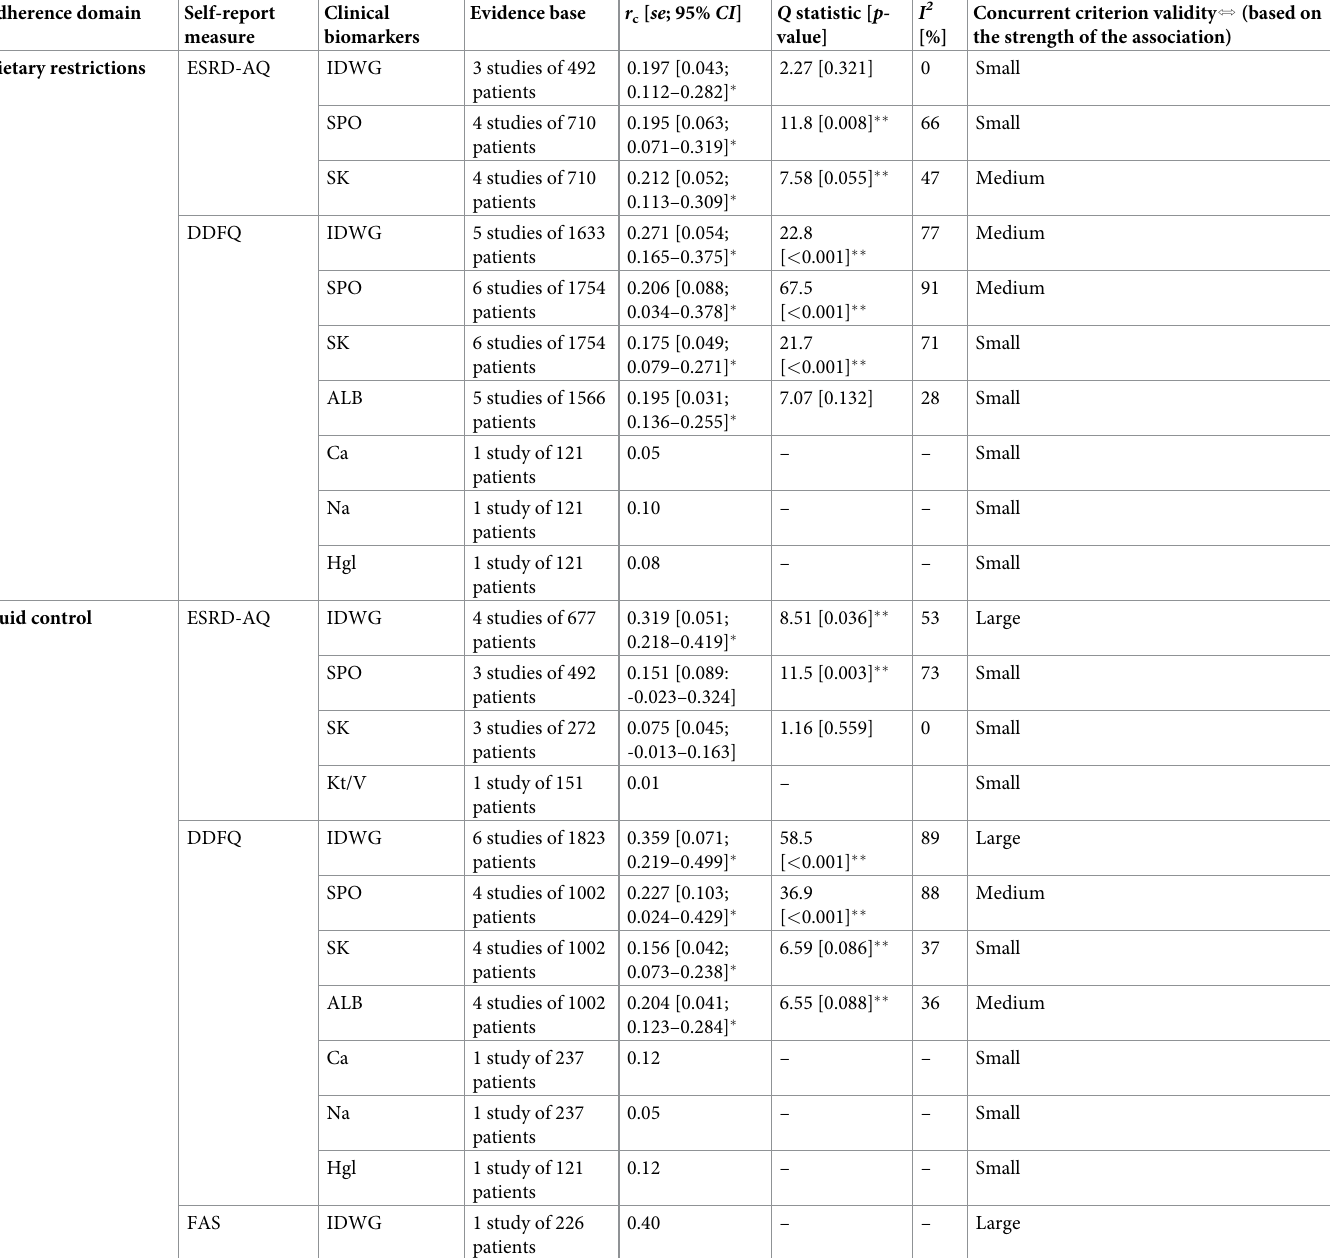
Table 2. Results of meta-analyses for concurrent criterion-related validity correlation coefficients between test scores and clinical biomarkers of adherence in hemodialysis. Adherence